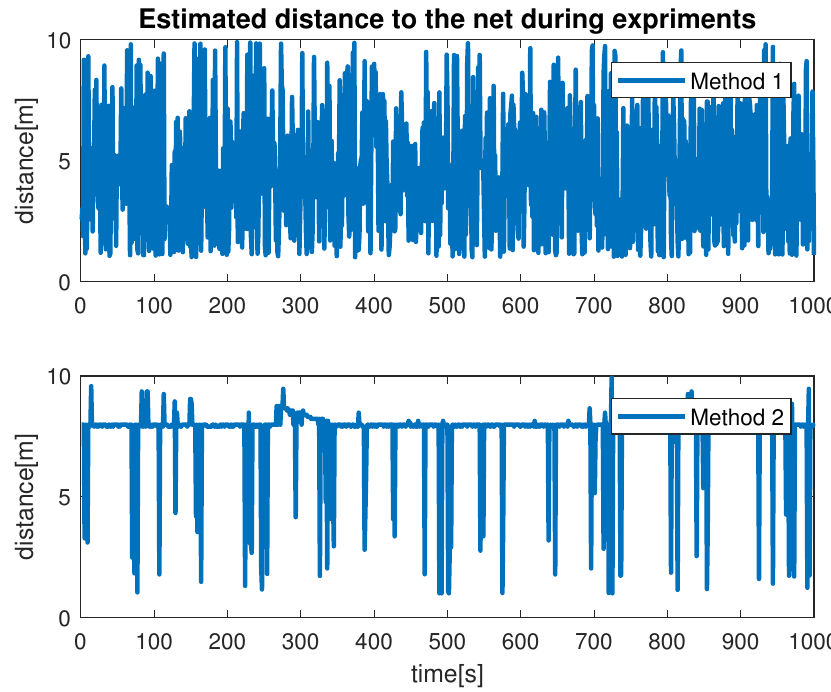
Figure 12. Fish cage net distance estimation during simulation.